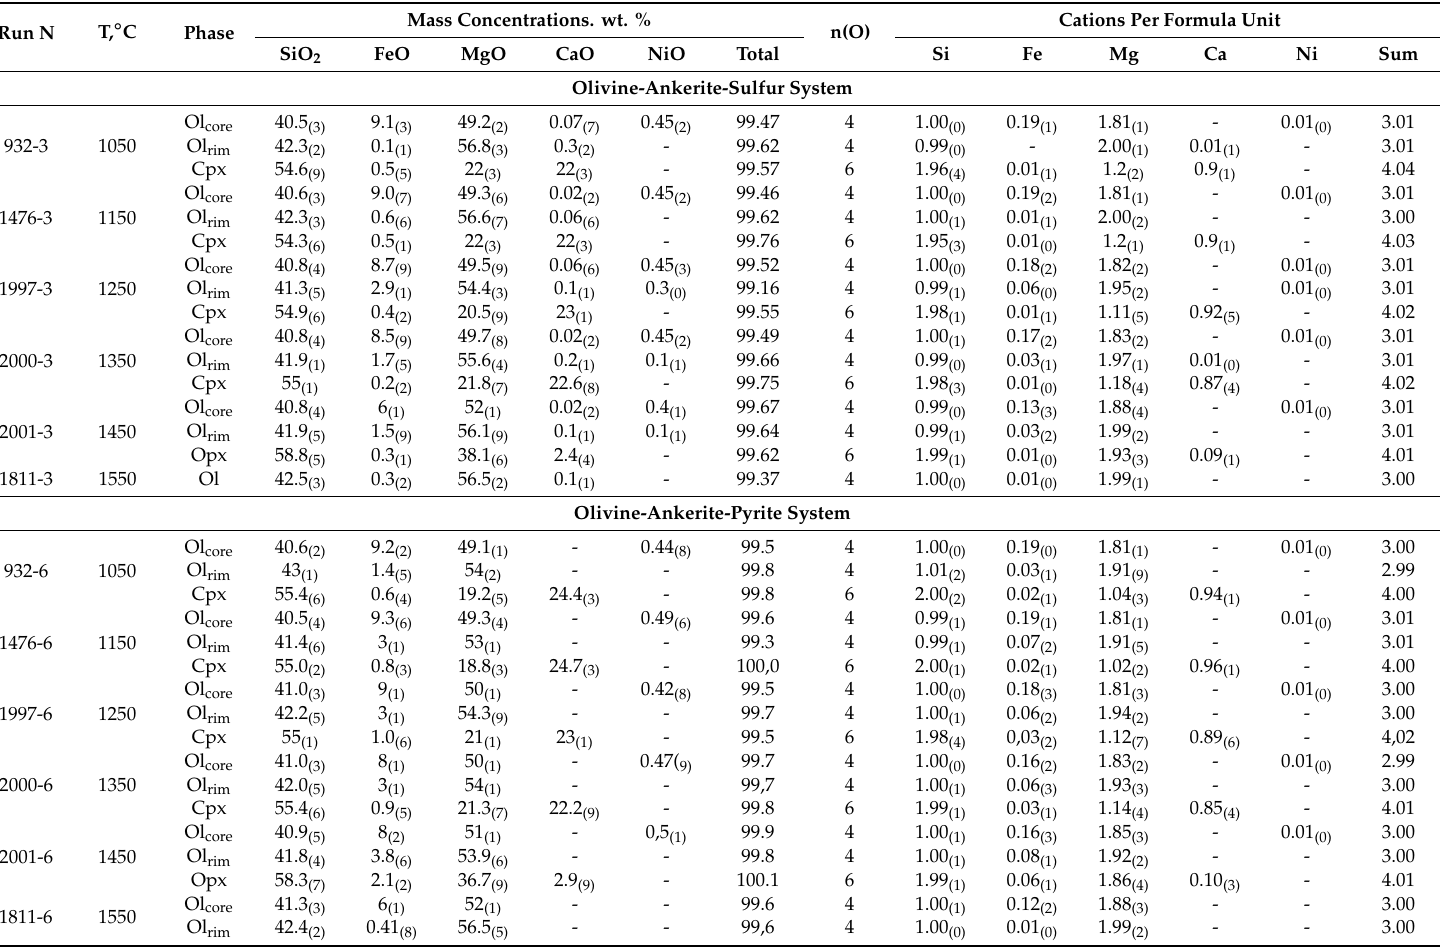
Table 3. Averaged compositions of